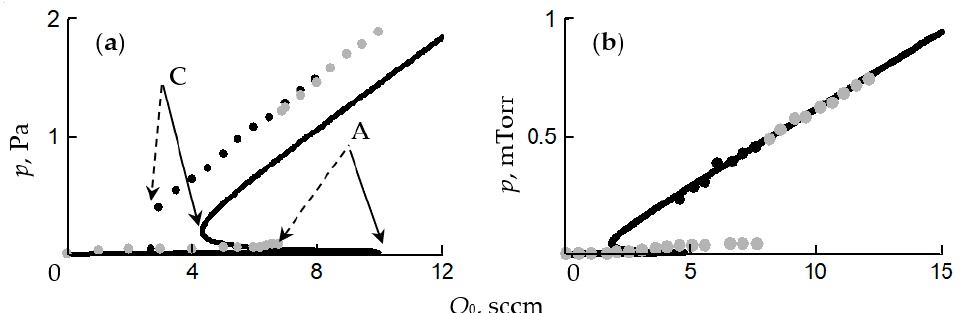
Figure 9. The results of the isothermal model application: ( a )—Ta 2 O 5 ; ( b )—TiO 2 . The results of the experiment are shown by dots: gray—increase in Q 0 ; black—decrease in Q 0 .